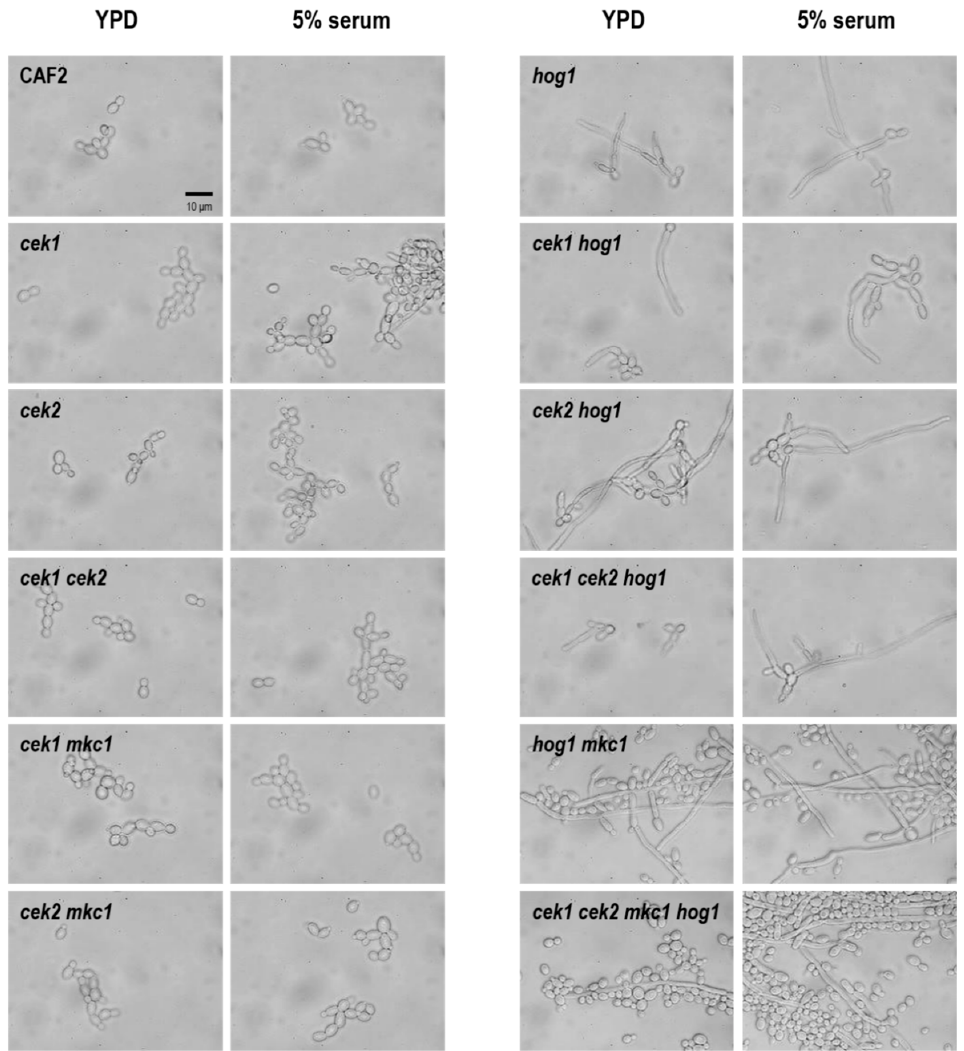
Figure 5. Yeast-to-hypha transition in liquid medium. 10 6 cells from overnight cultures were inoculated in YPD medium or 5% serum. Samples were observed after 5 h of growth at 30 °C and representative pictures are shown. All pictures were taken at the same magnification. Scale bar = 10 µm .